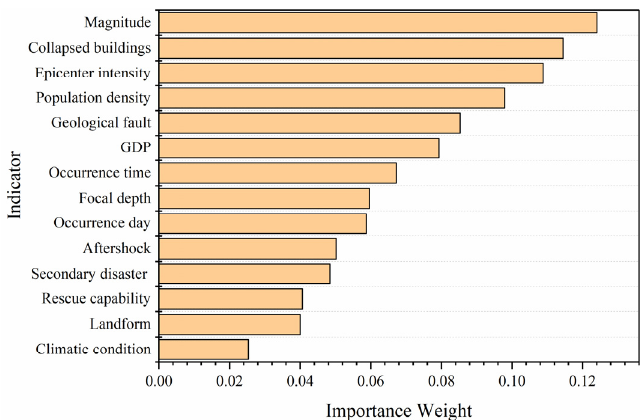
Figure 6. Importance weights of indicators on the index levels.